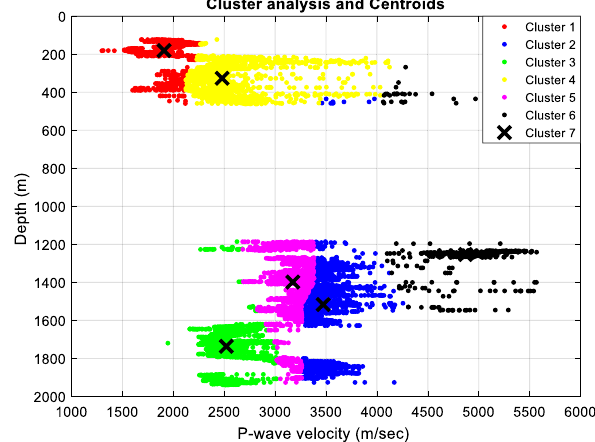
Fig. 7 Well-3 cluster analysis of P-wave